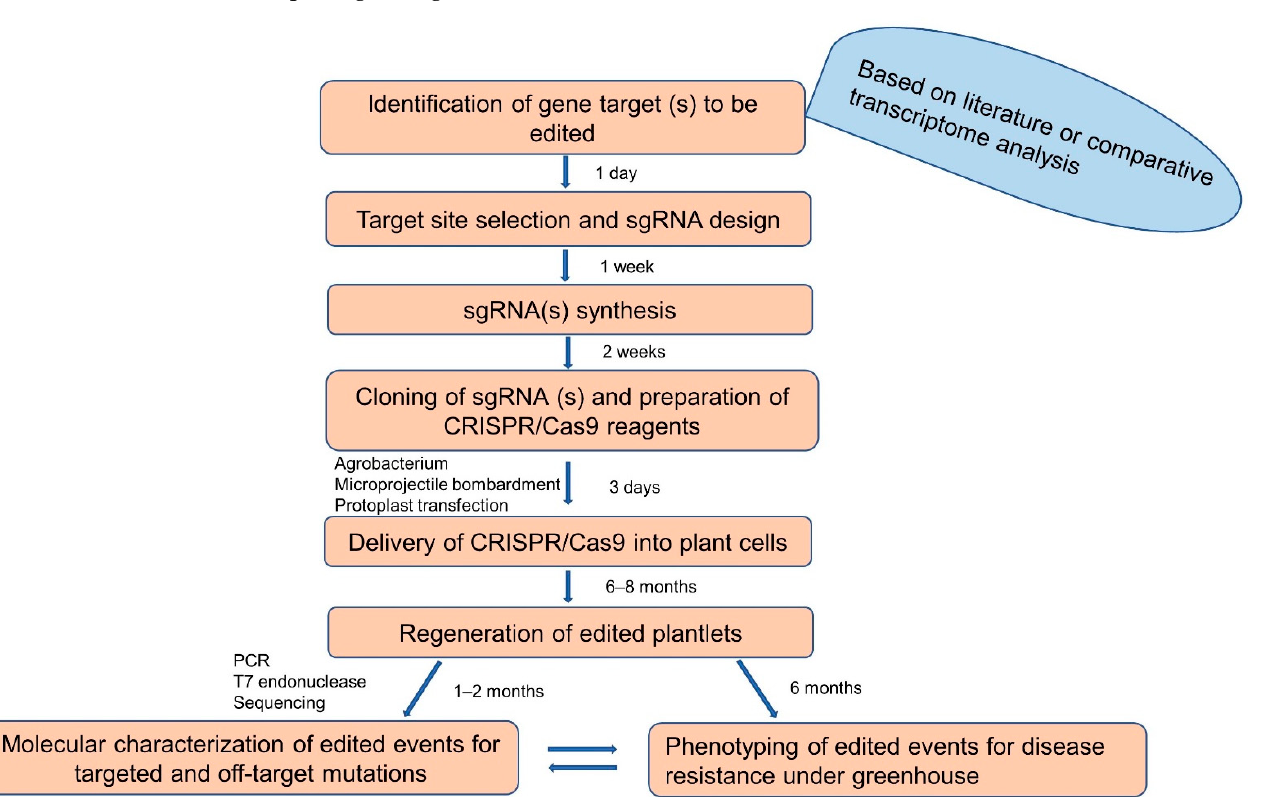
Figure 2. Flowchart illustrating steps and approximate time needed to develop gene-edited banana. sgRNA- synthetic guide RNA.